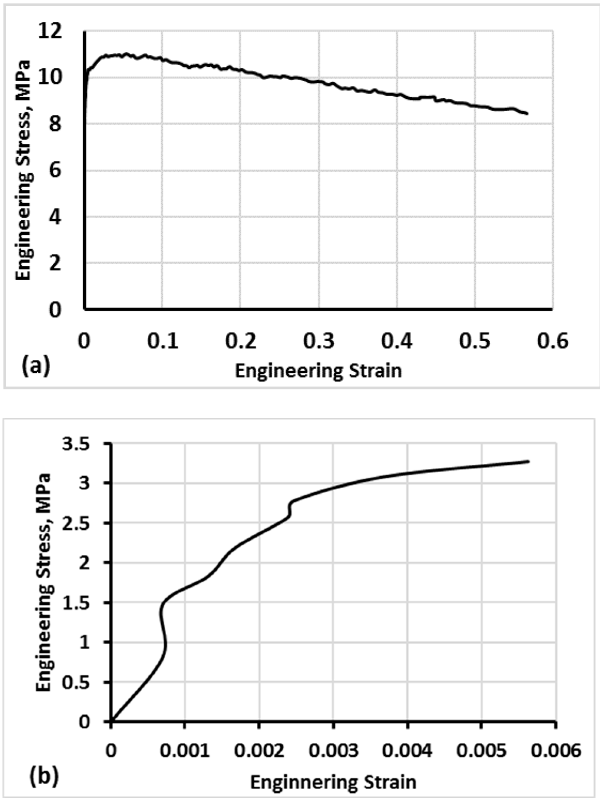
Figure 11. Stress-strain curves at the region of crack propagation, built from the results of the tests conducted at ( a ) 535 °C and ( b ) 571 °C.